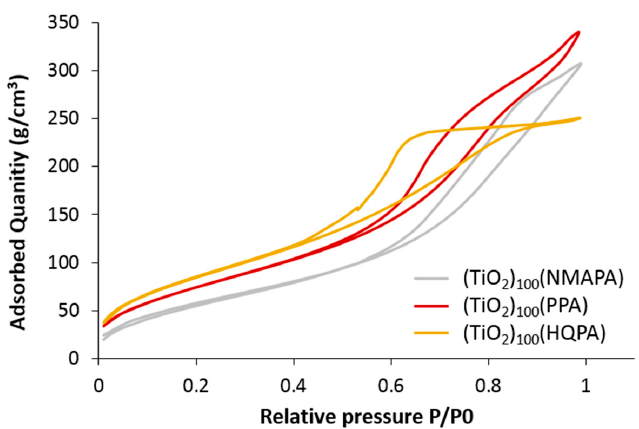
Figure 5. Nitrogen adsorption-desorption isotherms of (TiO 2 ) 100 (PPA), (TiO 2 ) 100 (NMAPA), (TiO 2 ) 100 (HQPA).